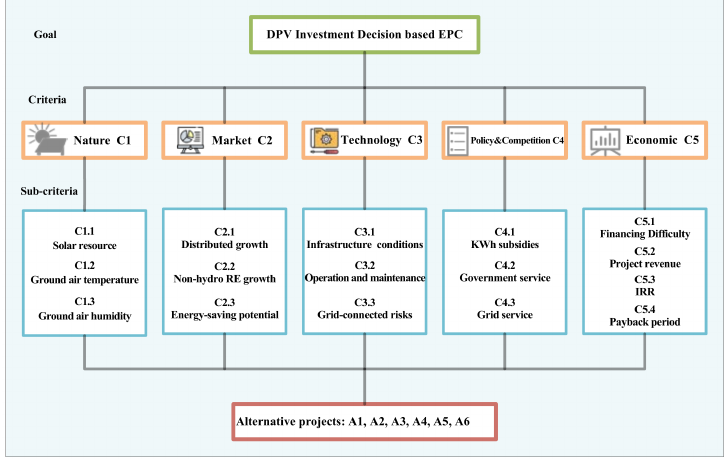
Figure 3. EPC-DPV Generation Project Investment Decision Criteria